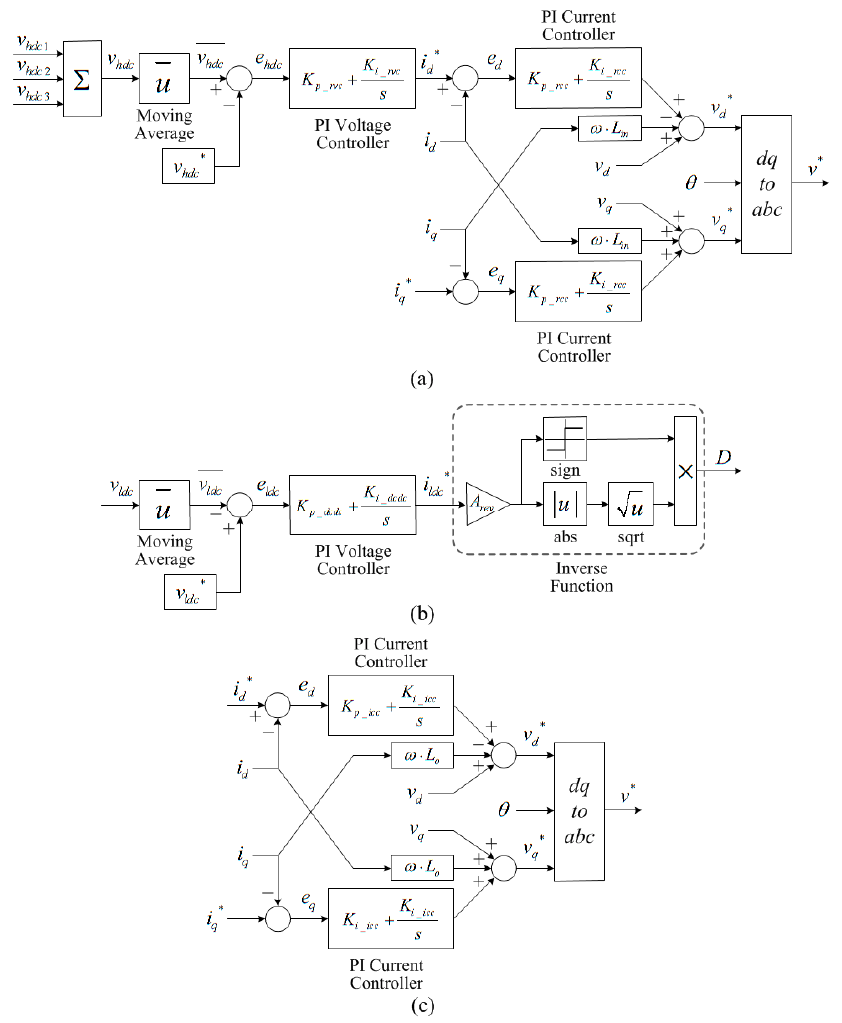
Figure 7. The overall control schemes for the SST system. The PI controller-based control scheme for ( a ) the cascaded multilevel rectifier, ( b ) the BiDUP converter, and ( c ) the singe-phase full-bridge inverter.